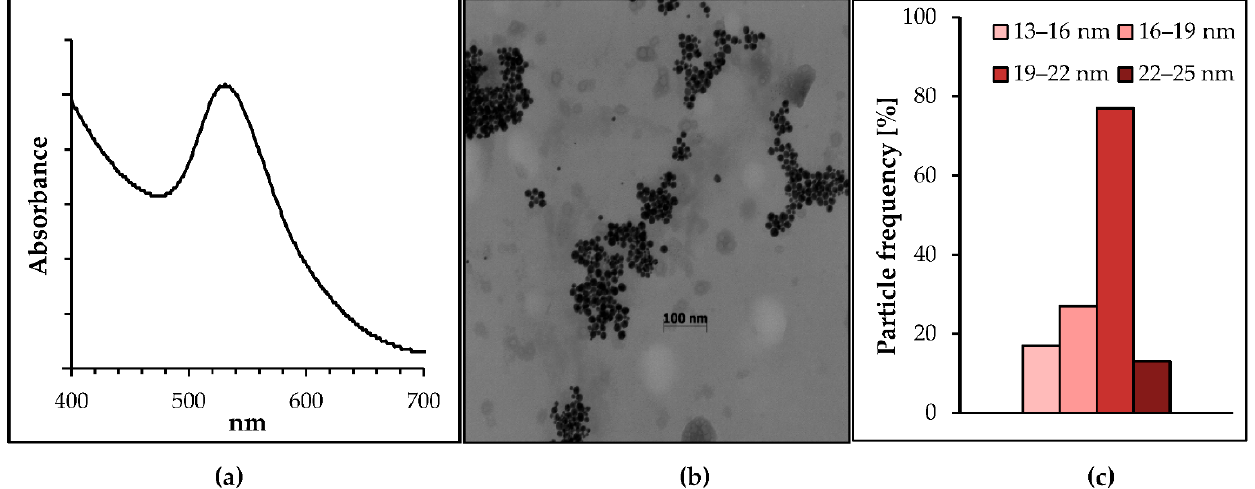
Figure 1. ( a ) Absorption spectrum of the biogenic gold nanoparticles; ( b ) TEM micrographs of the gold nanoparticles ( b ); ( c ) the particle size histogram of the gold nanoparticles.